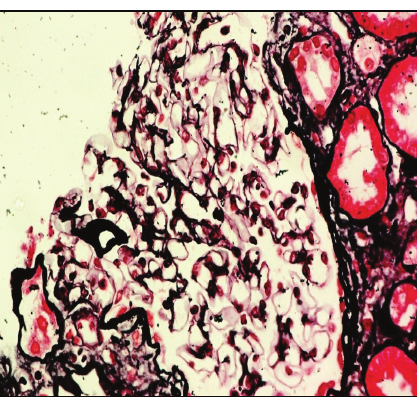
Figure 1: Irregular and thick basement membrane (H&E) and vaculizations of basement membrane of glomerulus (silver stain).